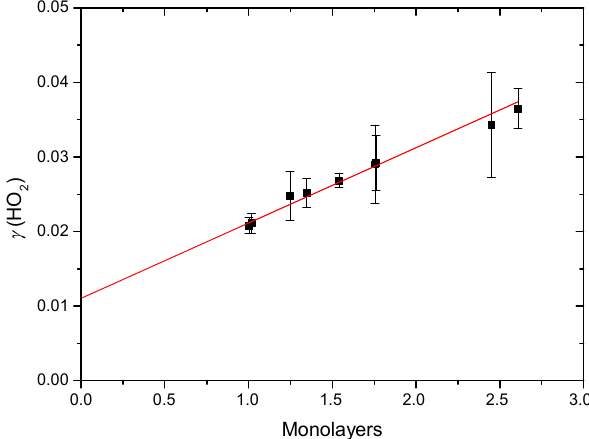
Figure 4. Reactive uptake coefficients of HO 2 , γ (HO 2 ), onto air- borne TiO 2 particles (black squares, left y axis) at different RH for T = 295 ± 2K. The number of monolayers of the adsorbed water on TiO 2 particles (red curve, right y axis) at 296K is also plotted as a function of RH, determined using FTIR spectroscopy (Goodman et al., 2001).